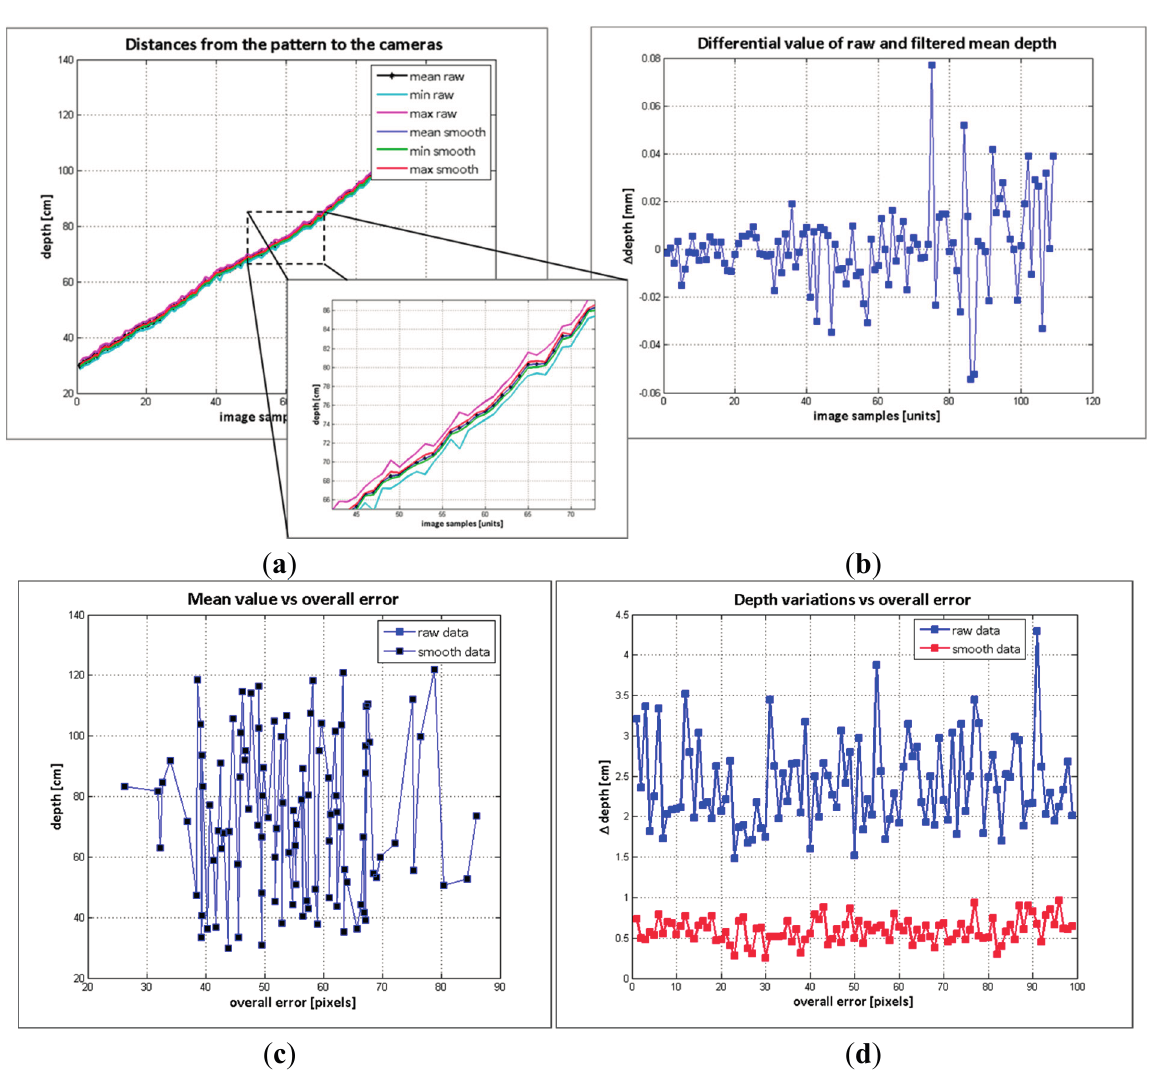
Figure 7. Depth measurements evaluation. ( a ) distances from the pattern board to the cameras; ( b ) differential value of raw and filtered data; ( c ) samples mean depth vs . overall error; ( d ) samples maximum variation vs overall